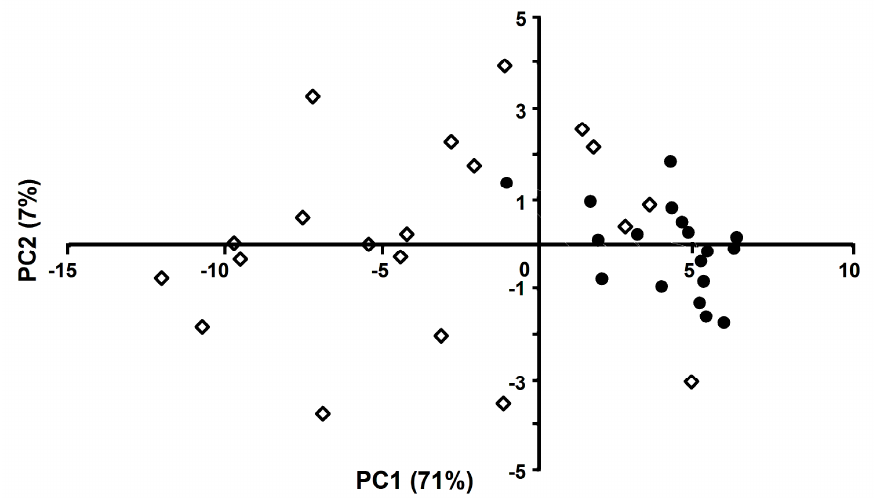
Figure 4. Results of the principle component analysis (PCA) performed for T2DM patient (opened diamonds) and normoglycemic (closed circles) groups. The analysis was based on all 42 differentially glycated peptides and indicated clear separation between the groups.